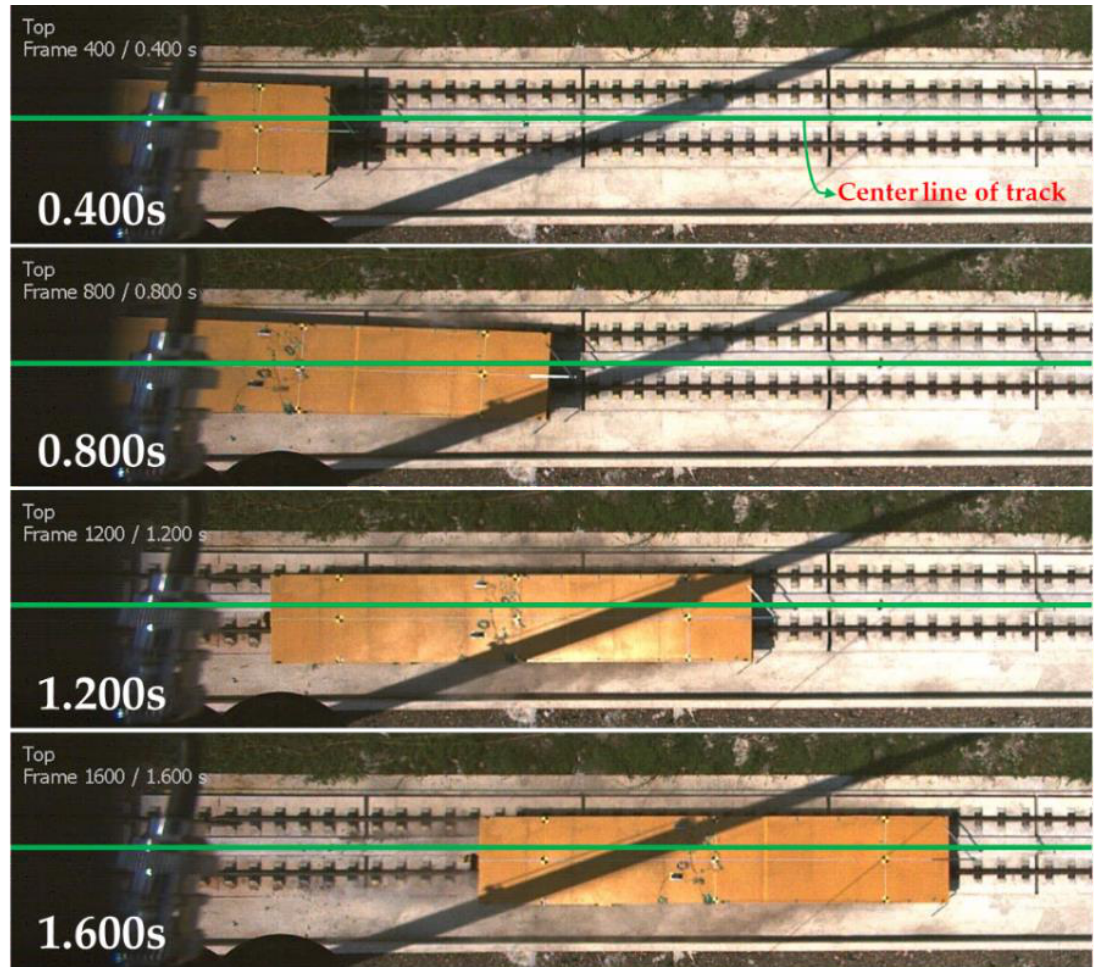
Figure 11. Post-derailment behavior of the flat wagon (top view).